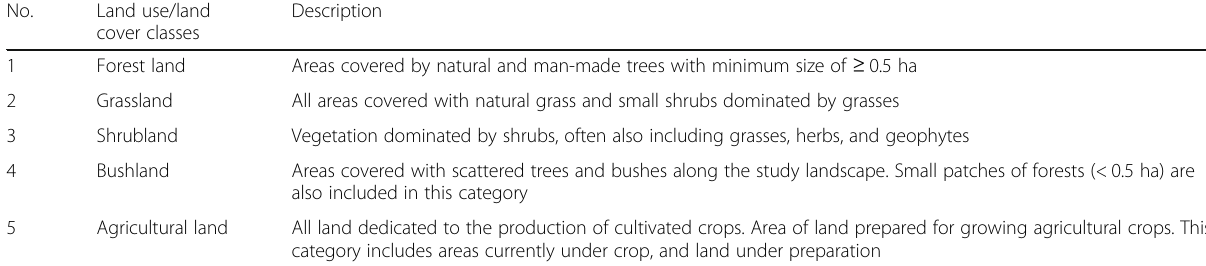
Table 8 Land use/land cover classes considered and their description in Sidama, South